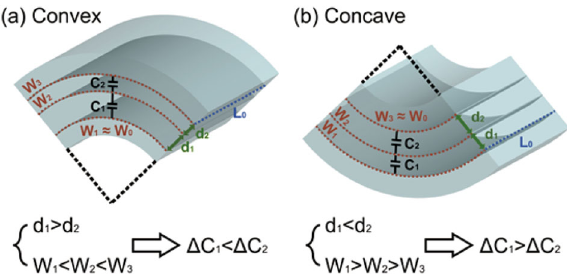
Fig. 5 Schematic view of dual-capacitor sensor bent in a convex and b concave shapes with the relative capacitance changes of the two stacked